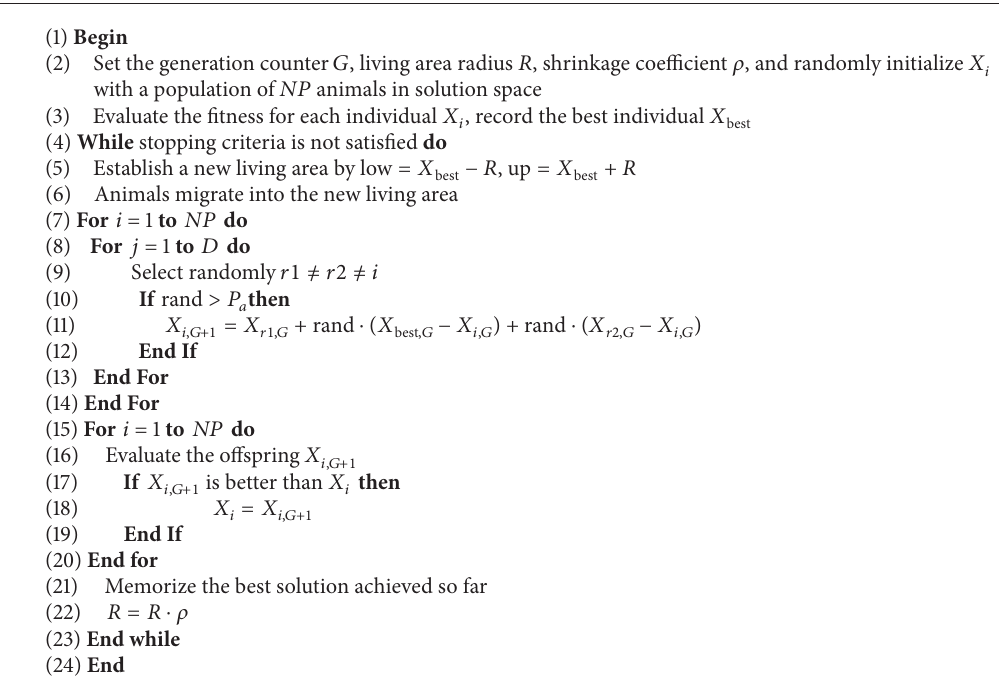
Algorithm 2: An improved animal’s migration optimization algorithm